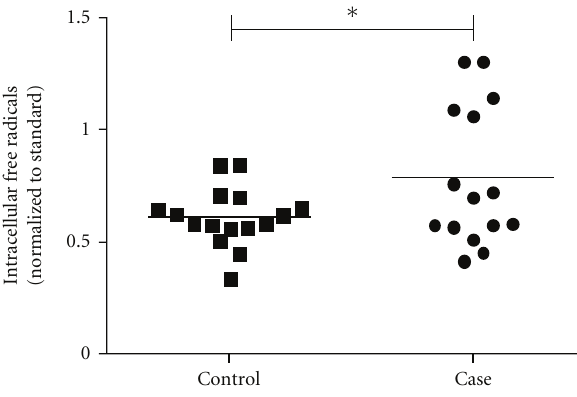
Figure 2: Intracellular Free Radicals are Elevated in Lymphocytes from Children with Autism. Intracellular free radicals were mea- sured in freshly isolated PBMC from children with autism and una ff ected control children using 1uM DCF. Presented is median fluorescent intensity (MFI) of the gated lymphocyte population from subject samples normalized to MFI of a standard PBMC preparation also treated with 1 uM DCF and analyzed with each subject sample. Lymphocytes from children with autism exhibited a significantly higher mean level of intracellular free radicals than controls ( P = 0 . 04). Control median (95% CI) = 0.576 (0.551– 0.640); case median (95% CI) = 0.689